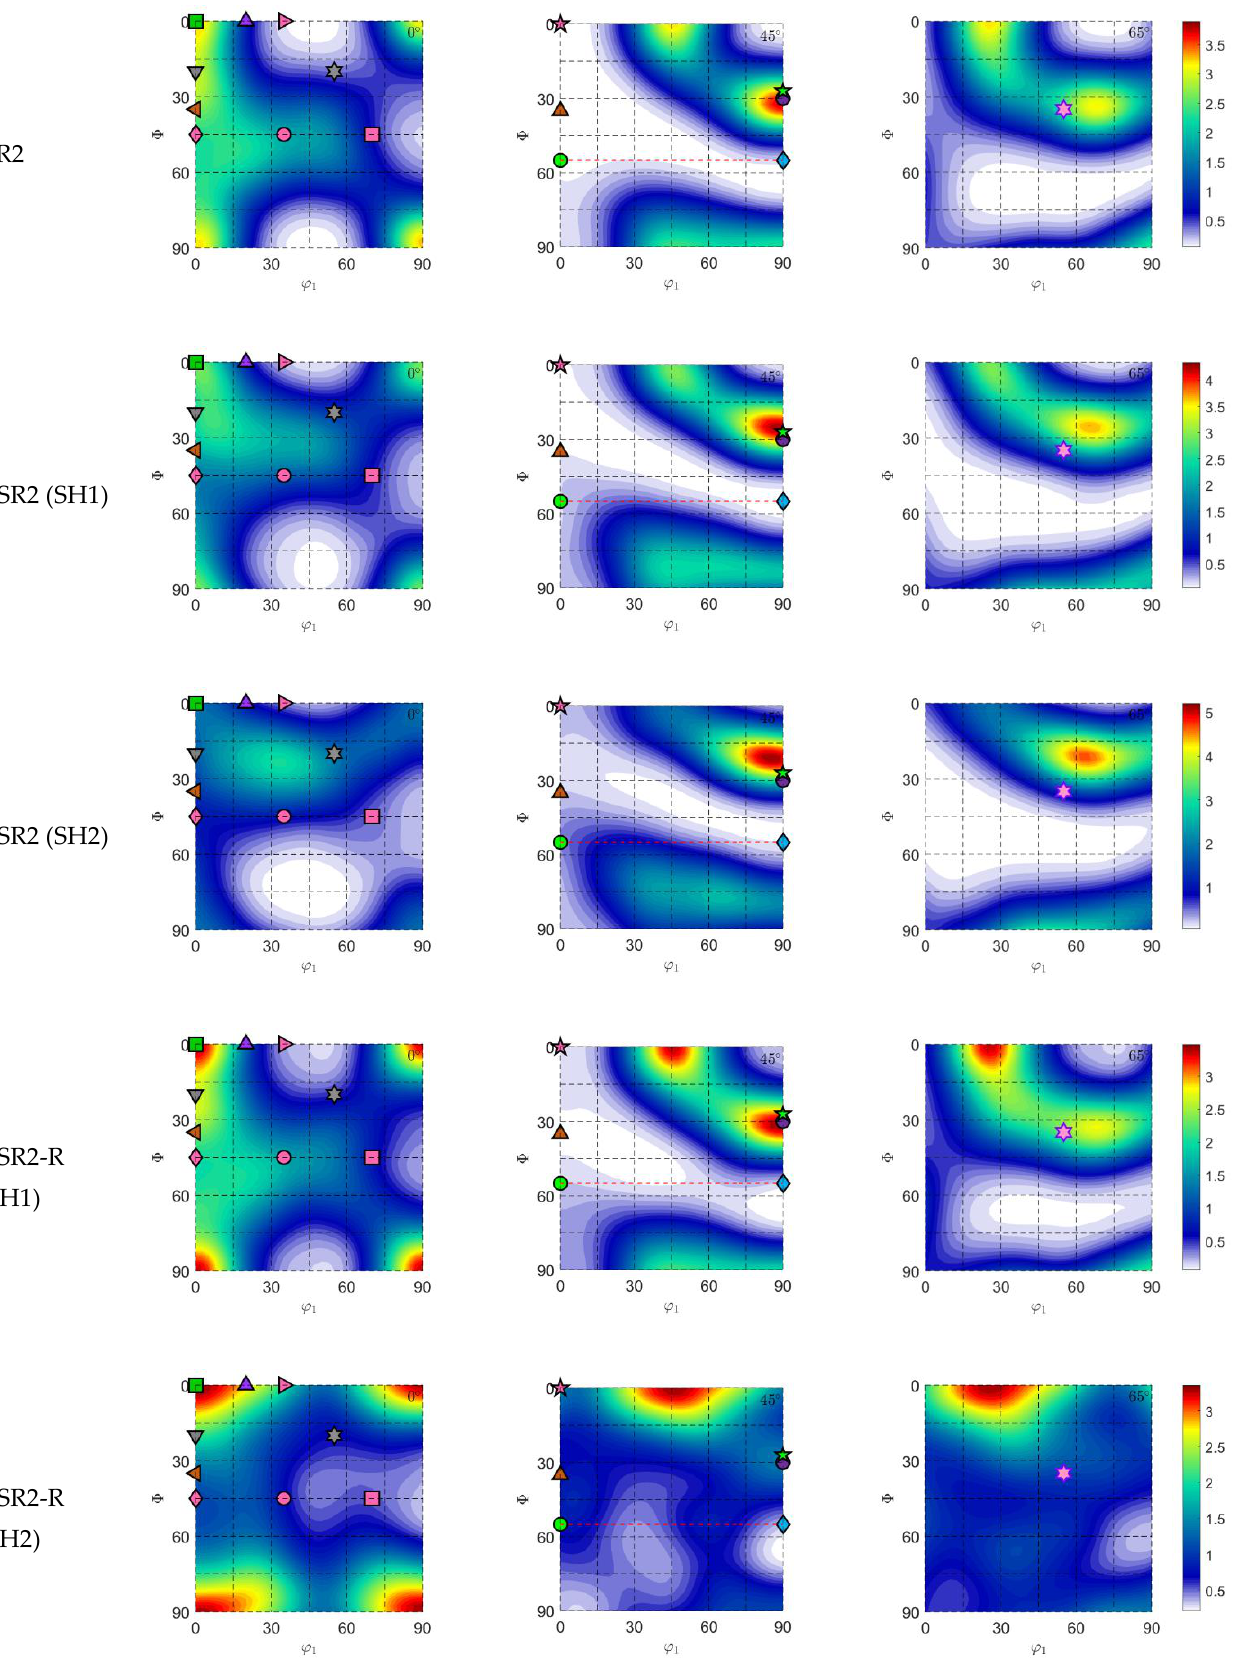
Figure A3. ODF for the second pass with a 20% thickness reduction per